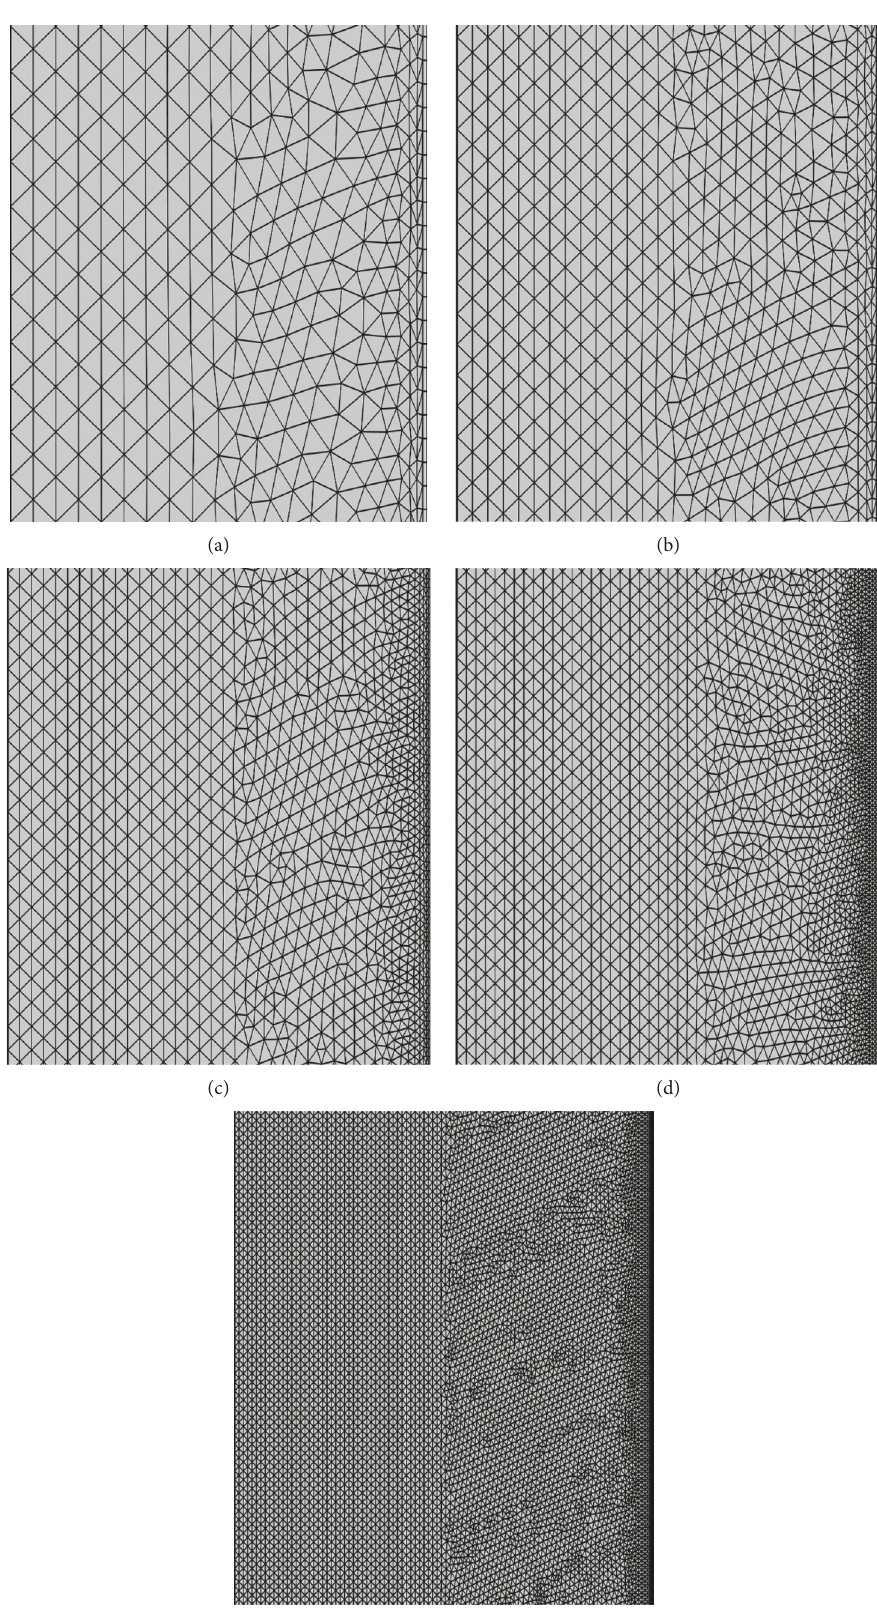
Figure 2: Meshing process of the geometry with the number of elements. (a) Normal mesh with 8489 elements; (b) fine mesh with 16442 elements; (c) fine mesh with 34206 elements; (d) extremely fine mesh with 71606 elements; (e) extremely fine mesh with 184809